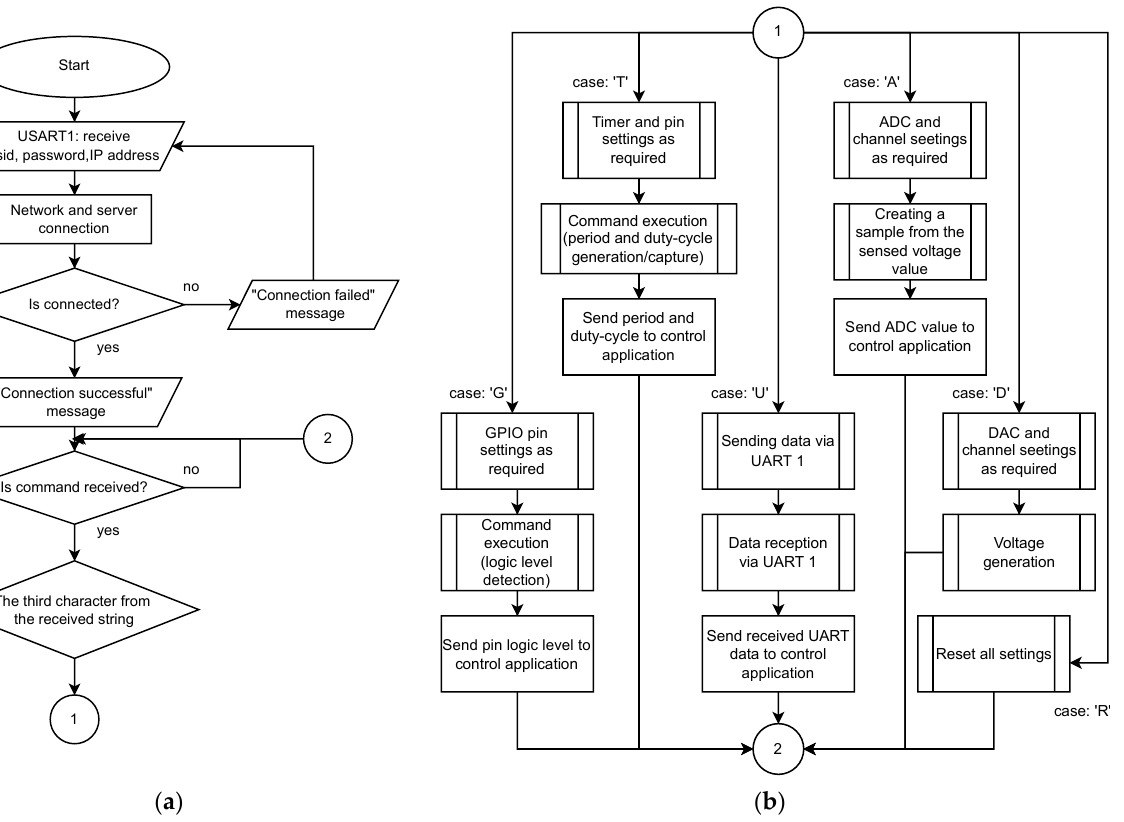
Figure 7. The last flowchart shows how the IoT monitoring device works. The flowchart consists of